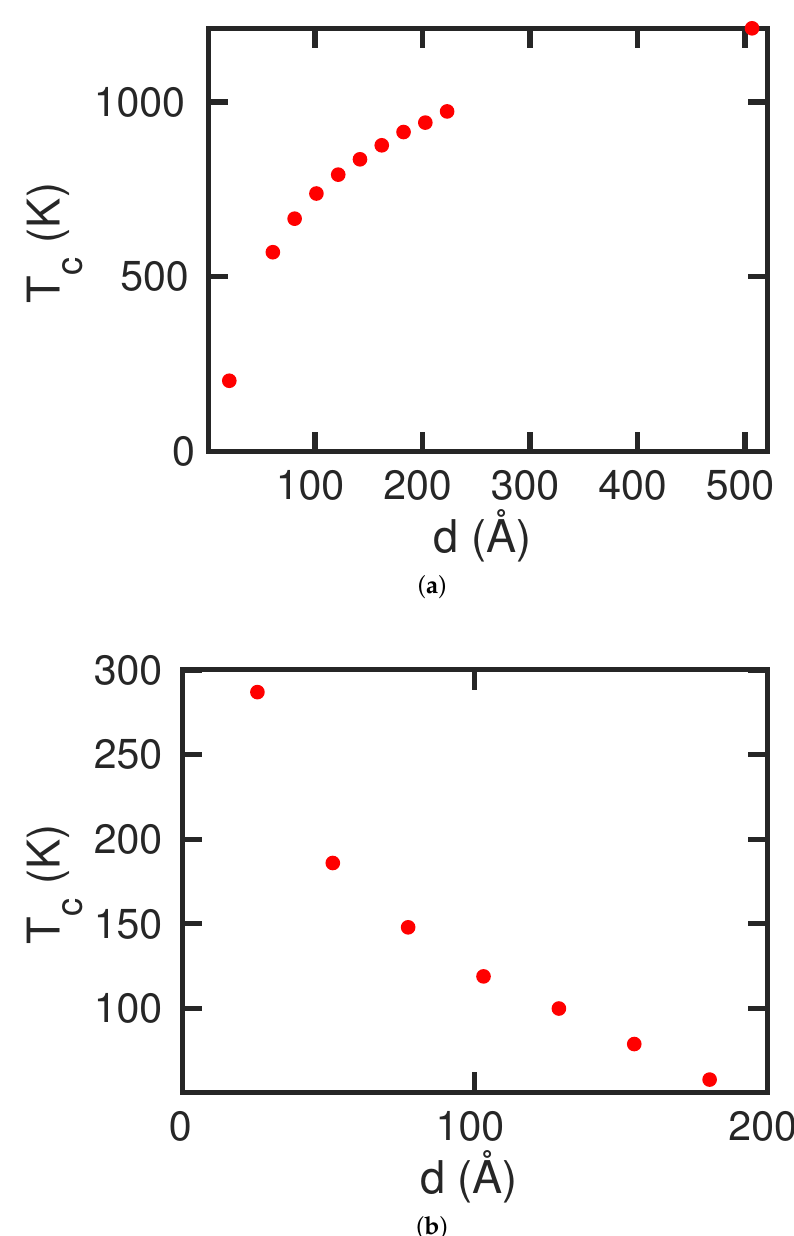
Figure A1. Dependence of the transformation temperature T c on the thickness d of the slab: ( a ) austenitic transformation; and ( b ) martensitic